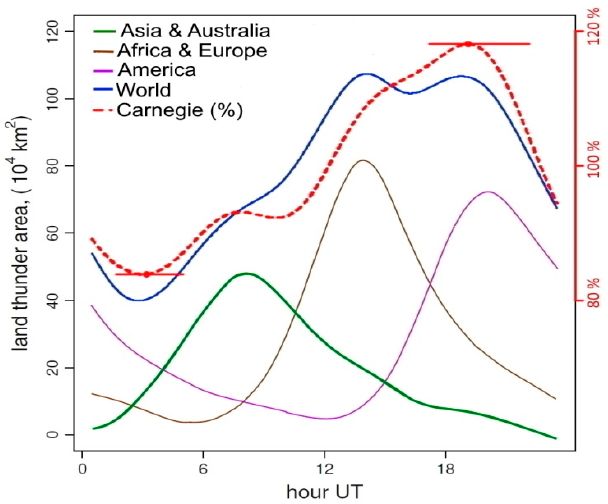
Figure 1. Carnegie curve and distribution of thunderstorms over the Earth’s